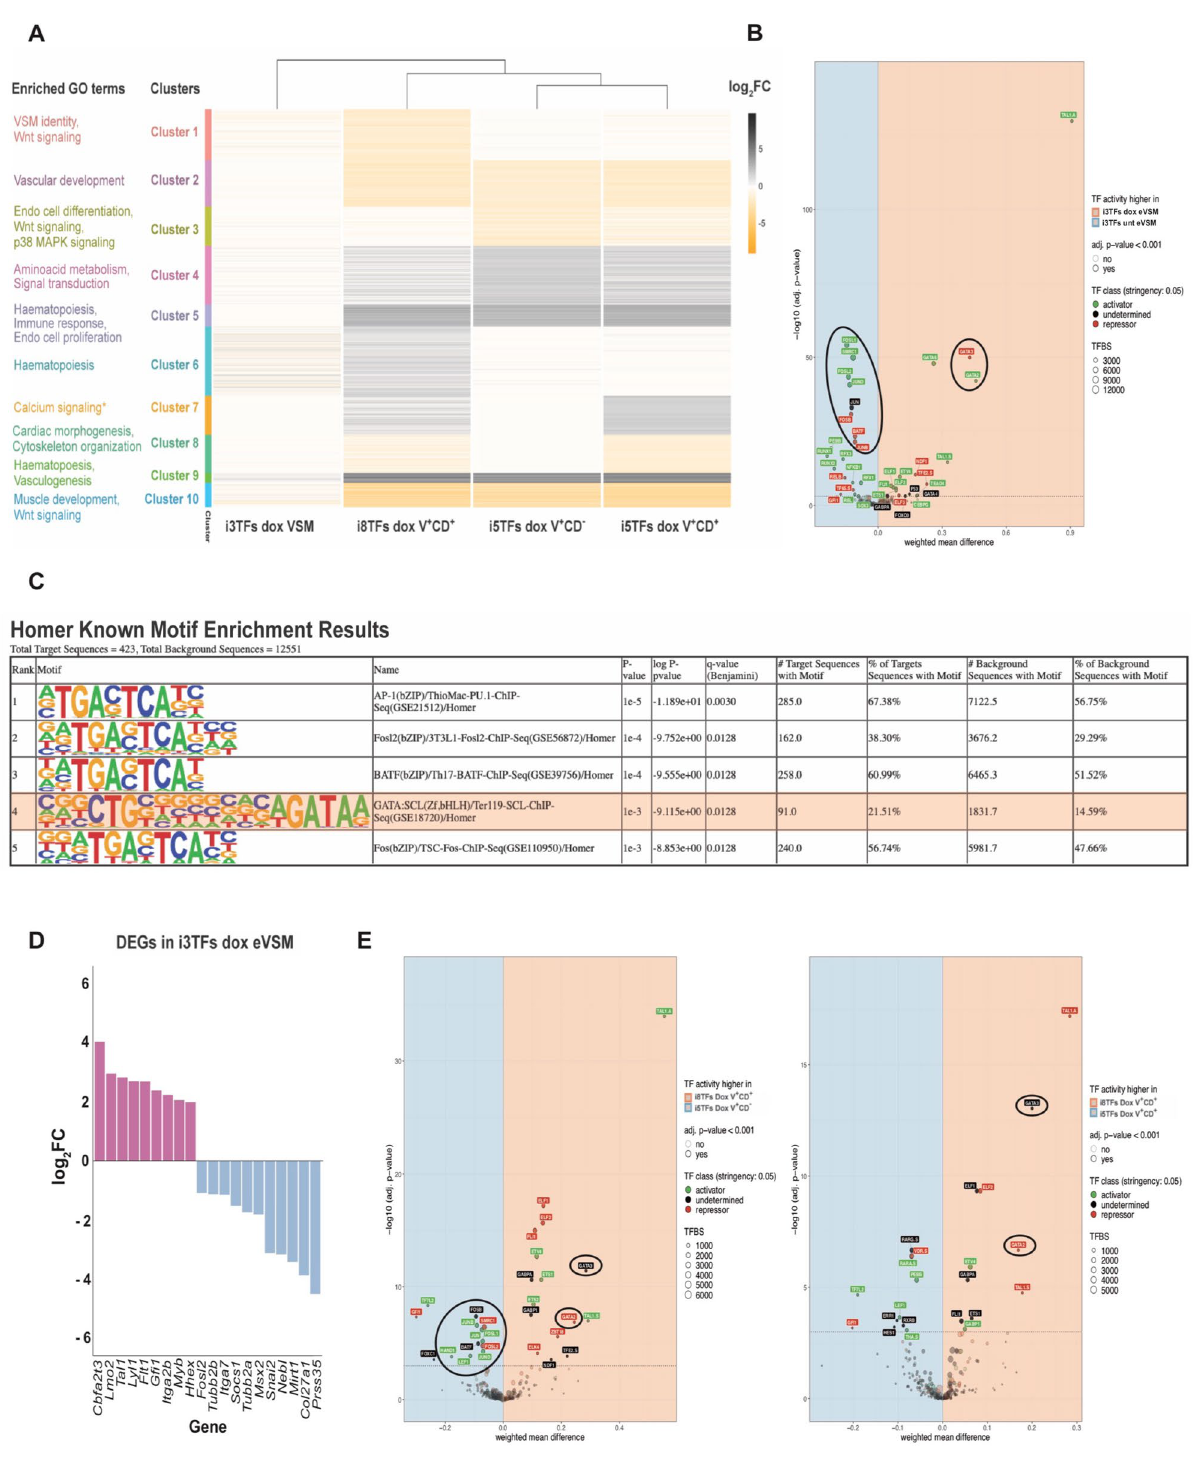
Figure 5. 3TFs overexpression contributes to the silencing of the muscle transcriptional program and the activation of the hematopoietic one in eVSM. ( A ) Heatmap showing the expression of genes from the clusters indicated in the figures. The most representative GO terms enriched in each cluster are shown in the left. * KEGG enrichment (no significant GO terms could be found for cluster 7). ( B ) diffTF volcano plot comparing i3TFs untreated (unt) eVSM to i3TFs dox-treated (dox) eVSM. A detailed explanation of the plot can be found in Fig. 3. TFs characteristic of VSM cells and hematopoietic TFs are circled. ( C ) Results of the “Known Motif Enrichment” analysis performed with the HOMER software on the differentially expressed genes in i3TFs dox eVSM. The top 5 enriched transcription-factor motifs are shown. The Tal1 motif is highlighted in orange. ( D ) Selection of differentially expressed genes (DEGs) comparing i3TFs unt eVSM to i3TFs dox eVSM. Hematopoietic genes are shown in pink, VSM-related genes are shown in blue. ( E ) diffTF volcano plots comparing i8TFs V + CD + to i5TFs V + CD + (left panel) and i8TFs dox V + CD + to i5TFs dox V + CD − (right panel). A detailed explanation of the plots can be found in Fig. 3. VSM and hematopoietic TFs are